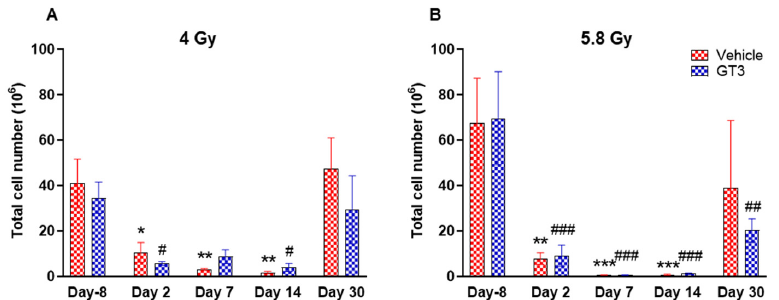
Figure 3. Effects of 4 Gy ( A ) and 5.8 Gy ( B ) on total leukocyte population in the BM of NHPs. NHPs received GT3 (37.5 mg/kg) or vehicle 24 h prior to irradiation (4 Gy and 5.8 Gy). BM was collected at various time points and expression of leukocytes were analyzed. Data are expressed as mean ± SEM. * p < 0.05, ** p < 0.01, *** p < 0.001 vs. vehicle day-8; # p < 0.05, ## p < 0.01 ### p < 0.001 vs. GT3 day -8.